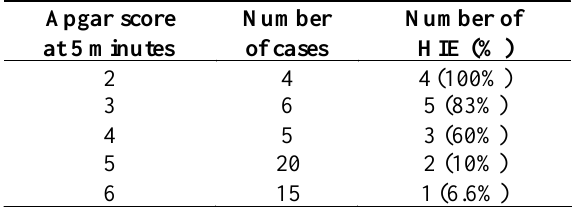
Table II: Correlation of 5 minutes apgar score and incidence of HIE